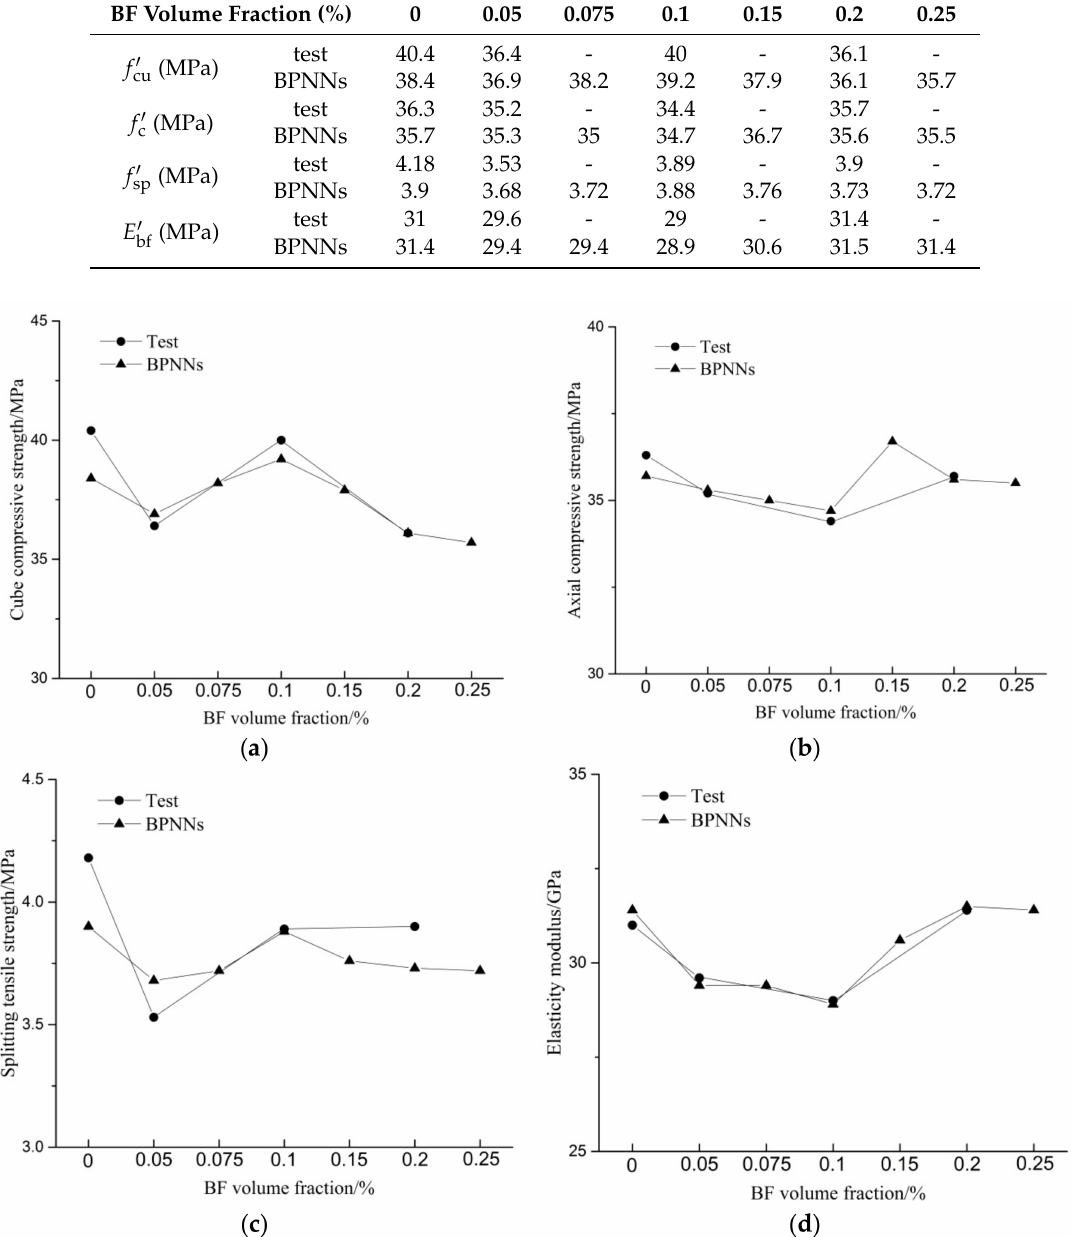
Table 7. Comparison between tests and BPNN predictions.